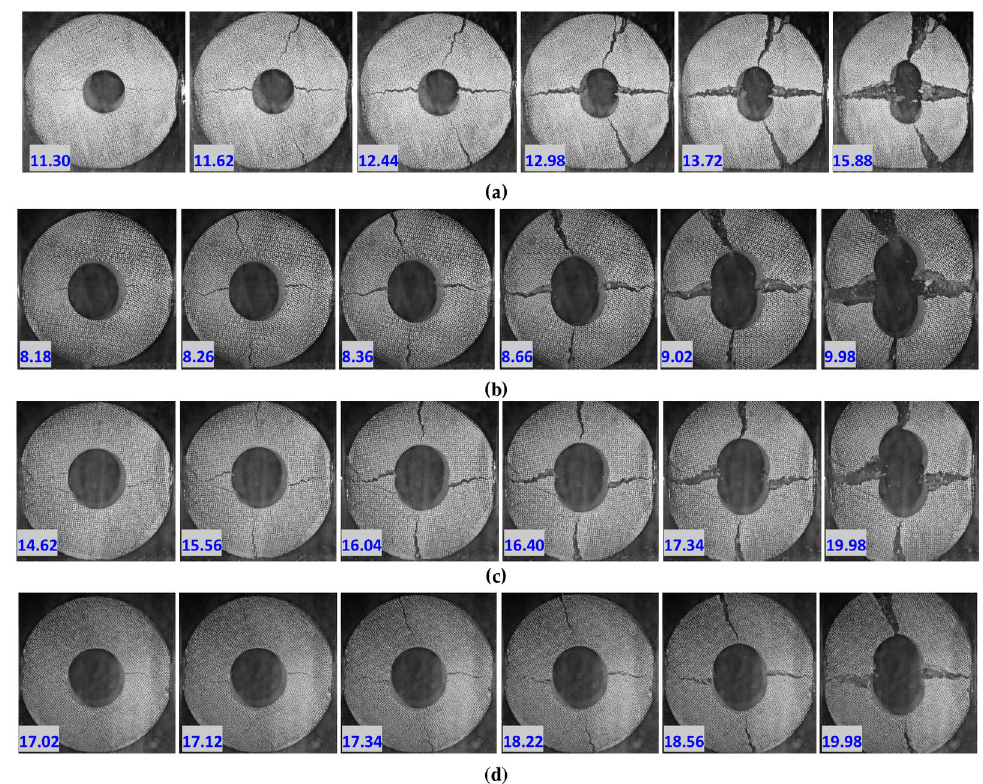
Fig 7. Damage history process of circular granite under a radial impact load (the number in the figure represents the moment when the camera took the photo; for example, 11.3 represents the time of 11.3 ms when the shooting started). (a) Sample GD1-3. (b) Sample GD2-2. (c) Sample GD3-4. (d) Sample